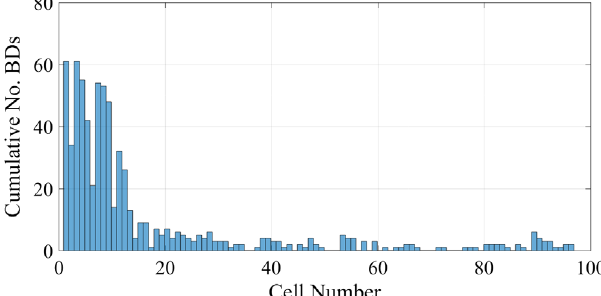
FIG. 34. Calculated breakdown position with respect to the phase at which it occurred. The breakdown position is given in time where 0 ns correspond to the first cell and 104.5 ns correspond to the final cell in the